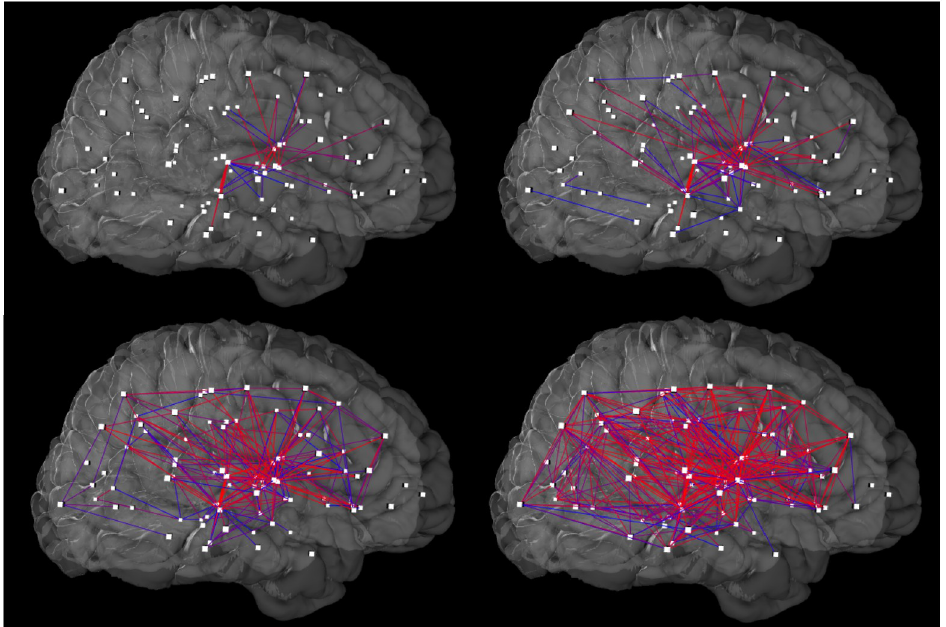
Fig 1. Four snapshots of the growing-tree-like object, prepared by the Budapest Reference Connectome Server https://connectome.pitgroup.org. From the upper left panel, clockwise: edges, present in at least 389 graphs; edges present in at least 322 graphs, in 230 graphs and in at least 122 graphs. (Settings for image generation: 20 k fibers, minimum edge weight 0, sagittal view).